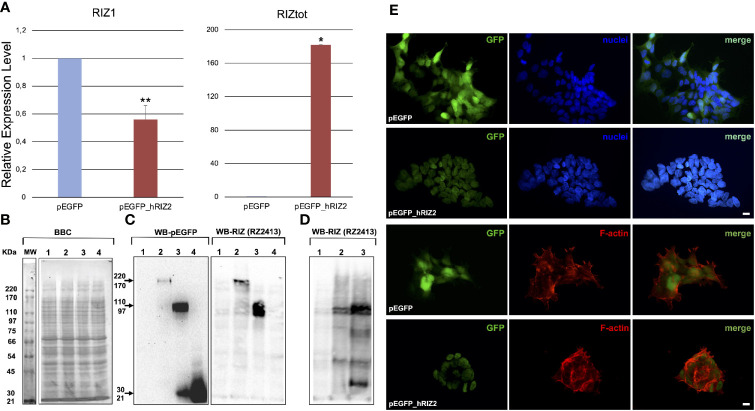

RIZ2 overexpression in HEK-293 cell line.
(A) Histograms represent the relative expression level of RIZ1 and RIZtot by qRT-PCR analysis using two sets of primers: 118F/438R recognizing sequences on exons 3 and 5 (exclusive of RIZ1) and 649F/975R recognizing a C-terminal region common to both RIZ1 and RIZ2 and indicated as RIZtot. The relative expression level is indicated as fold changes from HEK 293-pEGFP cells. Data were obtained from three independent experiments and expressed as mean ± SD. **p < 0.01 and *p < 0.0005 for RIZ1 or RIZtot versus control. (B) A representative Coomassie brilliant blue (BBC) stained gel. (C, D) Representative western blot analyses of total cell lysates from HEK-293 cells transiently (C) or stable (D) transfected with pEGFP or pEGFP_hRIZ2. Antibodies against RIZ (RZ2413) and EGFP were used in western blotting analysis. Sample 1, empty vector; sample 2, HEK 293-pEGFP_hRIZ2; sample 3, pEGFP-hRIZaa923-COOH; sample 4, pEGFP). (E) Immunofluorescence analysis of GFP (left panel) and F-actin (lower section, middle panel) in HEK 293-pEGFP and HEK 293-pEGFP_hRIZ2. Nuclei are stained in blue (upper section, middle panel). Merged images are shown in the right panels. The images shown are representative of three independent experiments. Images were captured using a DC480 camera (Leica) and acquired by Application Suite (Leica) software.